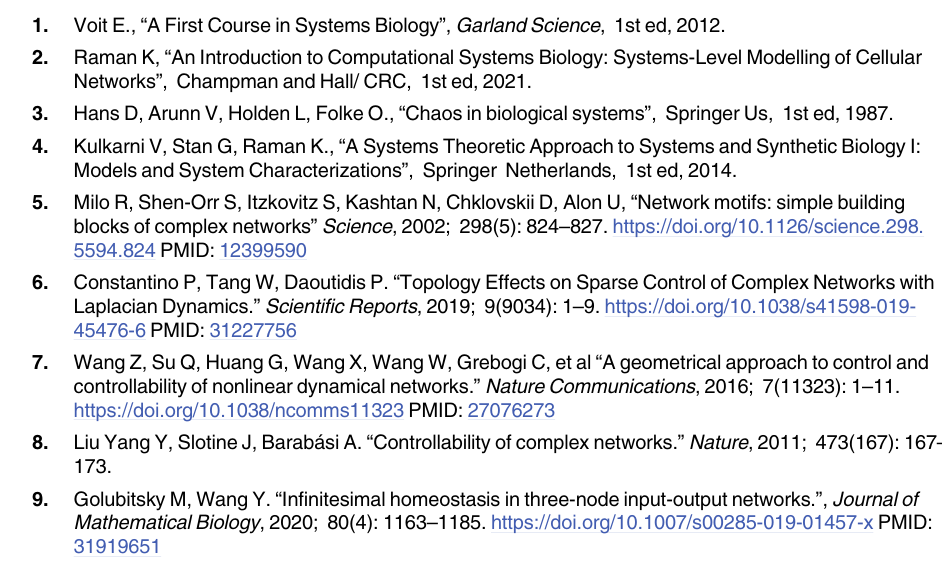
S9 Fig. Five-node NFBLB used for simulation. S10 Fig. Three-node IFFLP along with a downstream node. S11 Fig. Three-node NFBLB along with a downstream node. S1 Table. Consolidated table: demonstration of the algorithm.